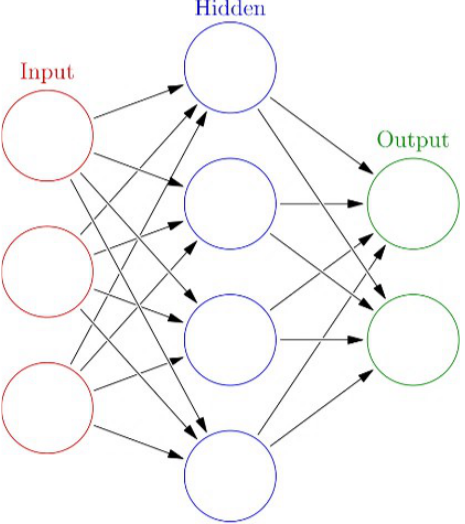
Figure 3. A simple structure of an artificial neural network (ANN) model, including the input and output layers, as well as only one hidden layer. The input layer consists of input data (conditioning factors), and the output layer is a probability map which shows the wildfire susceptibility.